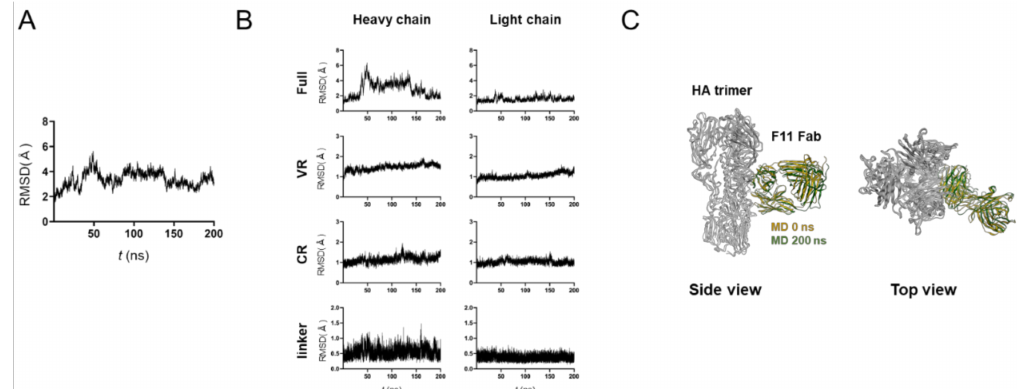
Figure 2. MD simulation of glycosylated HA trimer docked to the F11 Fab fragment. The top-2 complex was subjected to MD simulation at 1 atm and at 310 K in 0.15 M NaCl for 200 ns. ( A ) RMSDs between the structure of the initial HA-F11 Fab complex and those at the given time points of the MD simulation are shown. ( B ) RMSDs of structural units of the F11 Fab fragments during the MD simulations. The entire region (Full), variable region (VR), constant region (CR), and unstructured linker region between VR and CR (linker) are shown for the heavy chain (left panels) and light chain (right panels). ( C ) Superposition of the top-2 complex structures before and after 200 ns of MD simulations.